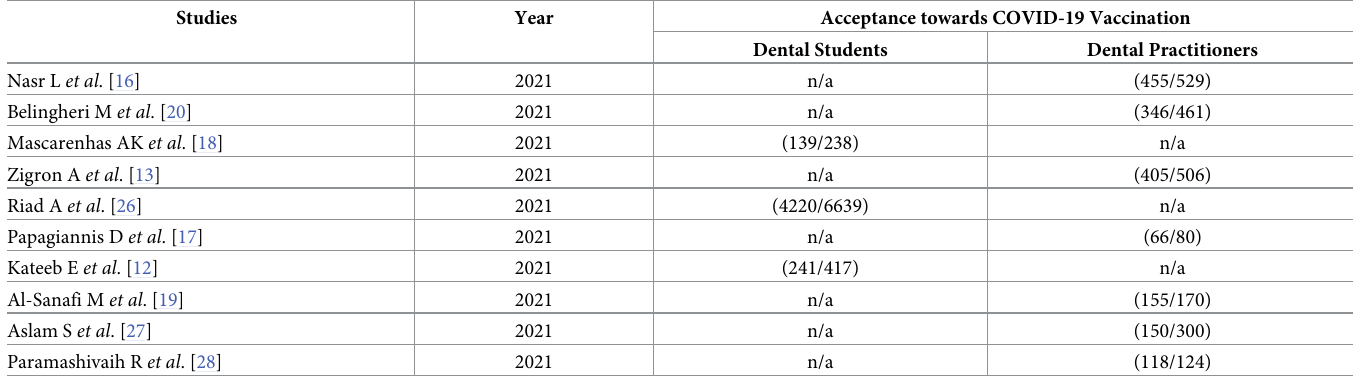
Table 3. Dental students and dental practitioners’ acceptance towards COVID-19